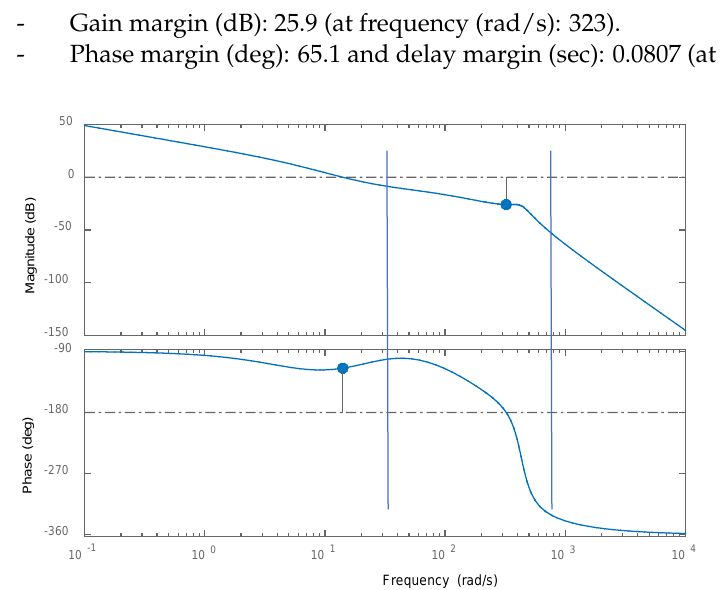
Figure 10. Bode characteristics showing the stability boundaries parameters for electrohydraulic drive with MFC controller.